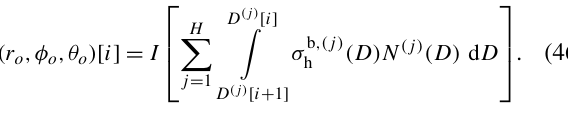
dinates ( r o , φ o , θ o ) the Doppler spectrum S in linear Z e units (mm 6 m − 3 ), for a given velocity bin i